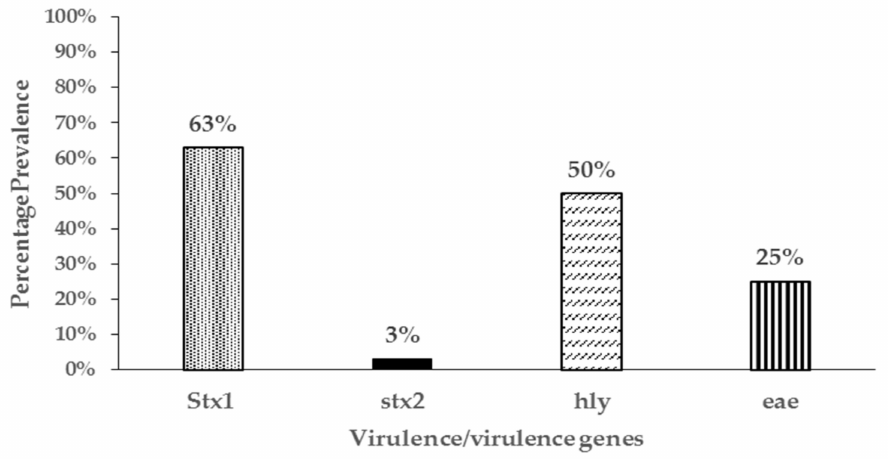
Figure 4. Prevalence of virulence genes in 104 antibiotic resistant E. coli isolates from pastured meat